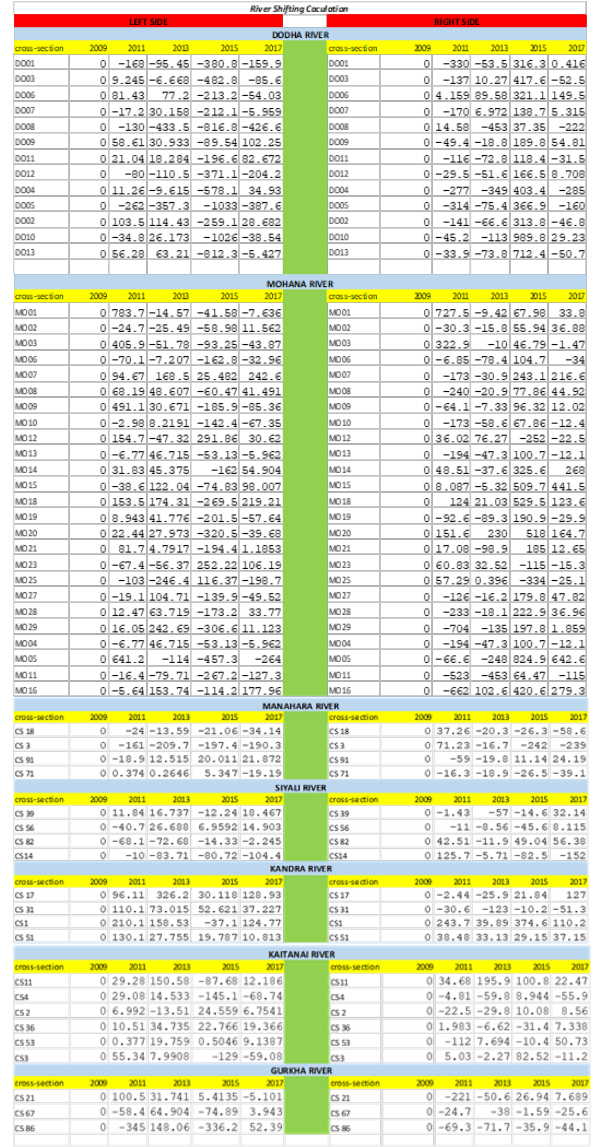
Table 4: Area of River Bank Erosion in different rivers of Mohana-Macheli Watershed